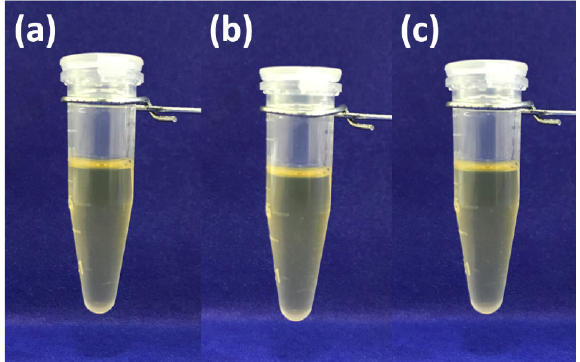
Fig. 3 Proof of stability of 1 wt% DCi in MO after (a) 24, (b) 168, and (c) 720 h.